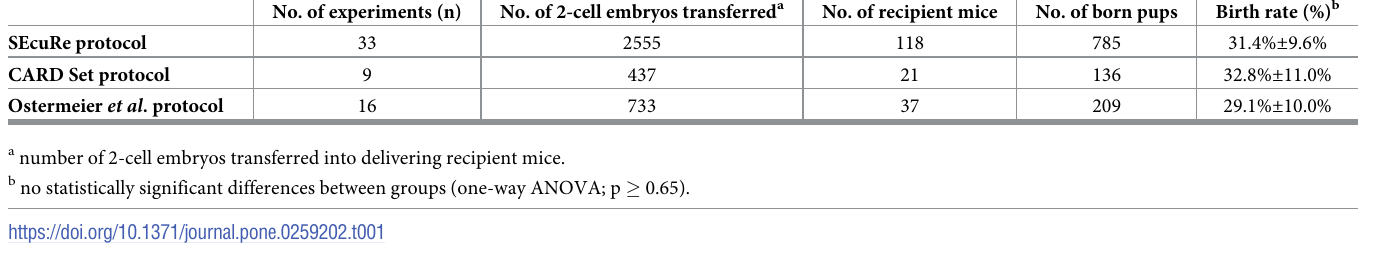
Table 1. In vivo development of 2-cell stage embryos produced with the SEcuRe, CARD Set and Ostermeier et al . protocols. No. of experiments